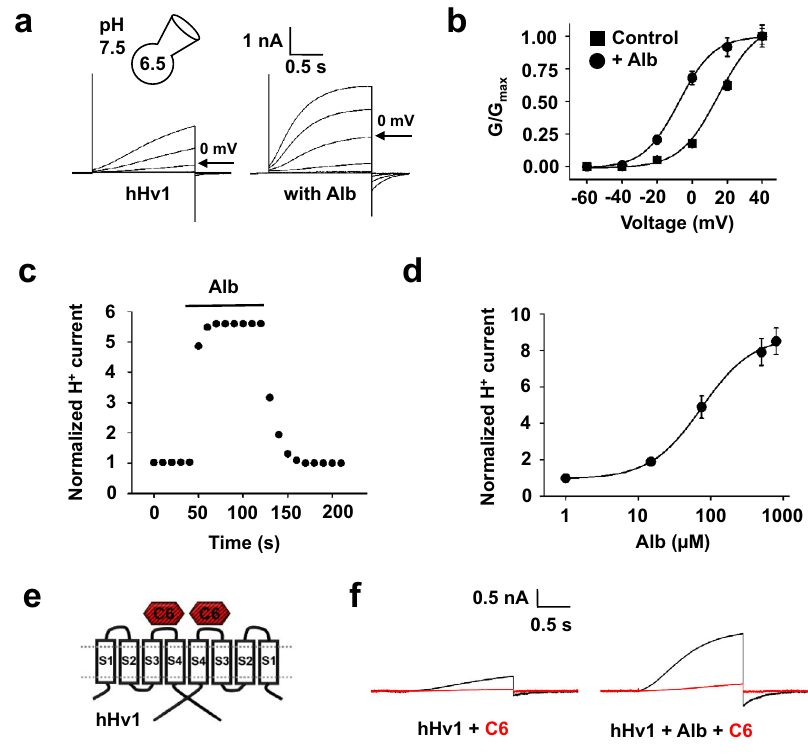
Fig. 3 Alb reversibly activates hHv1, shifting activation to more negative voltages. a Proton current for hHv1 channels expressed in HEK293T cells before (left), and in the presence of 75 µ M Alb (right), with steps of 20 mV from − 60 mV to + 40 mV. The current measured at the end of depolarization was used to determine the extent of activation. Fitting the activation and deactivation of proton currents at 0 mV to a single exponential function gave time constants τ act of 2619.8 ± 222.3 ms and 332.3 ± 30.6 ms, τ tail of 86.9 ± 8.4 ms and 235.0 ± 29.7 ms without and with Alb, respectively. b G-V for hHv1 in the absence (black squares) or presence of 75 µ M Alb (black circles). hHv1 channels showed a − 23 ± 3 mV shift after exposure to 75 µ M Alb from 15 ± 2 mV to − 8 ± 1 mV. Curves fi t to a Boltzmann equation, n = 6 cells. c Time course for activation and deactivation of hHv1 currents on acute application (bar) and washout of 75 µ M Alb. Currents were recorded at 0 mV. Values are normalized to the control current before the application of Alb. d Dose-response relationships for Alb activation of hHv1 at 0 mV. The EC 50 was estimated from a fi t to the Hill relationship to be 74.8 ± 8.7 µ M with a coef fi cient of 1.16 ± 0.11. Values are normalized to mean proton currents amplitude in the absence of Alb, n = 6 – 8 cells. e Cartoon showing two C6 peptides binding to an intact dimeric hHv1 channel. f C6 peptide (20 μ M, red trace) was applied to cells after control pulses (black trace) without Alb (left) or after pre-activation with 75 μ M Alb (right). C6 inhibited ~92% of hHv1 proton current (left), which is similar to the extent of inhibition (~89%) with Alb pre-activation (right). Values are mean ± SEM. Some error bars are smaller than symbols. Source data are provided in the Source Data fi